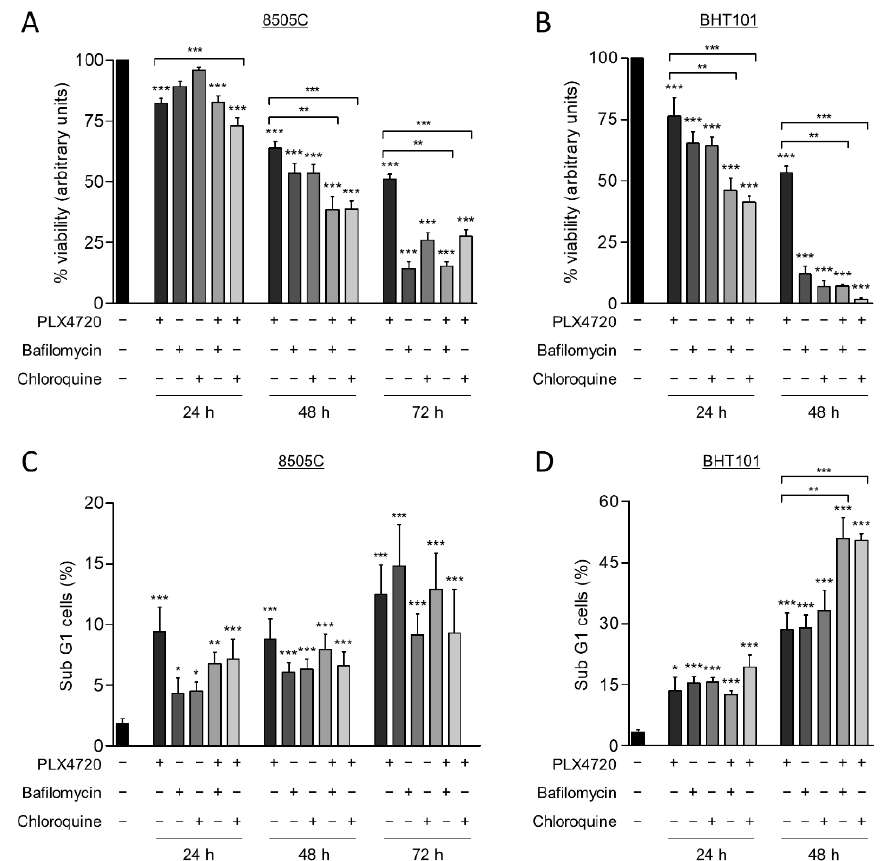
Figure 4. Autophagy blockage induces cell death and sensitize thyroid cancer cells to V600E BRAF inhibition. Cell viability measured by MTT assay in 8505C ( A ) and BHT101 ( B ) cells following 24, 48, or 72 h treatment with PLX4720, Bafilomycin A1 or Chloroquine alone, or with PLX4720 in combination with each of the autophagy inhibitors. Results shown are the mean ± SEM of three independent experiments performed in triplicate. Apoptosis was measured in 8505C ( C , D ) BHT101 cells treated as in ( A , B ), respectively, by quantitation of the sub-G1 fractions of PI-stained cells by flow cytometry. Results shown are the mean ± SEM of three independent experiments performed in duplicate. Significant differences compared to the corresponding controls: * 0.01 < p < 0.05, ** 0.001 < p < 0.01, *** p < 0.001.